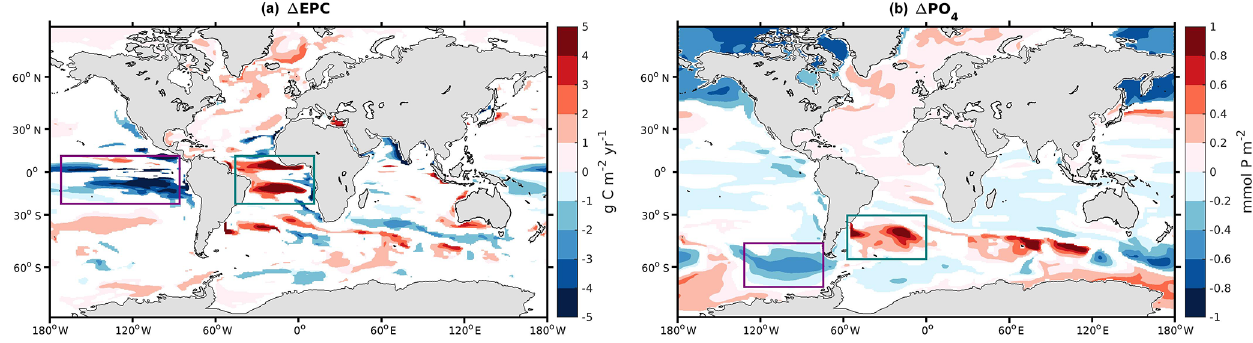
Figure 5. Difference in (a) export production of carbon at 100m depth ( (cid:49) EPC) and (b) phosphate at the surface ( (cid:49) PO 4 ) between 125 and 115ka. When the absolute value of the difference is below the standard deviation over the last 50 years at 125 and 115ka, the value returns a NaN. Purple and turquoise rectangles highlight the two “ocean tunnels” linking the sinking/upwelling regions of southern-sourced intermediate waters in our